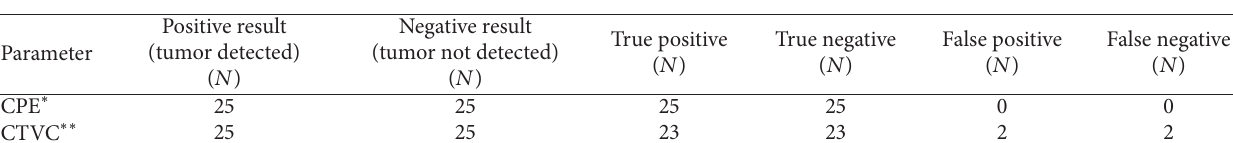
Table 1: (a) Tumor detection in patients with bladder tumors: taking CPE as reference standard, CTVC falsely detects two patients with tumor lesion out of twenty-five with no lesion on CPE. Similarly, CTVC fails to detect two patients out of twenty-five with lesion positive on CPE. (b) Depicting the sensitivity and specificity of CTVC for bladder tumor detection.